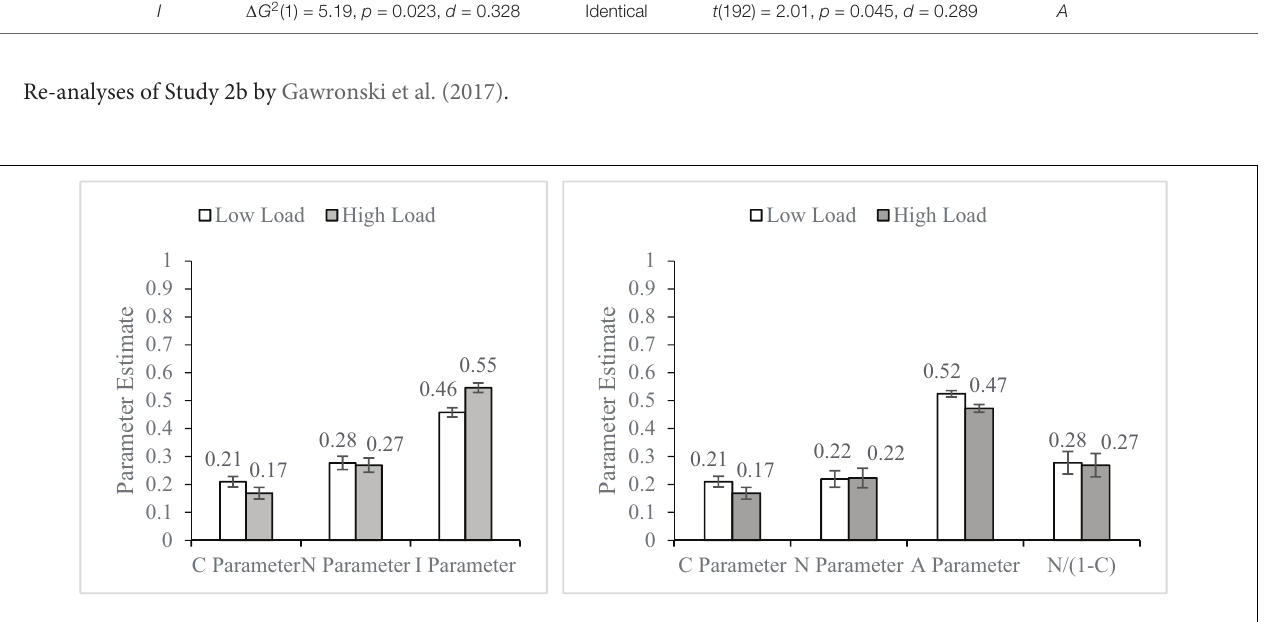
Results Parameters contrast